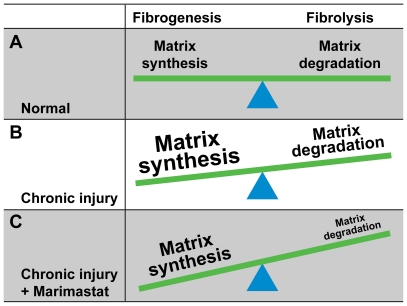
Broad-spectrum matrix metalloproteinase (MMP)-inhibition results in increased hepatic fibrosis following chronic hepatic injury.In the absence of liver injury a physiological balance exists between extracellular matrix synthesis and its degradation (A). Chronic hepatic injury causes excessive synthesis of extracellular matrix proteins including collagen, which prevails over their enzymatic degradation resulting in liver fibrosis (B). Despite a significant attenuation of fibrogenesis and inflammation, efficient inhibition of fibrolytic matrix metalloproteinases by a broad spectrum MMP-inhibitor has profound effects on collagen degradation, tilting the balance towards net extracellular matrix deposition and scar tissue formation (C).